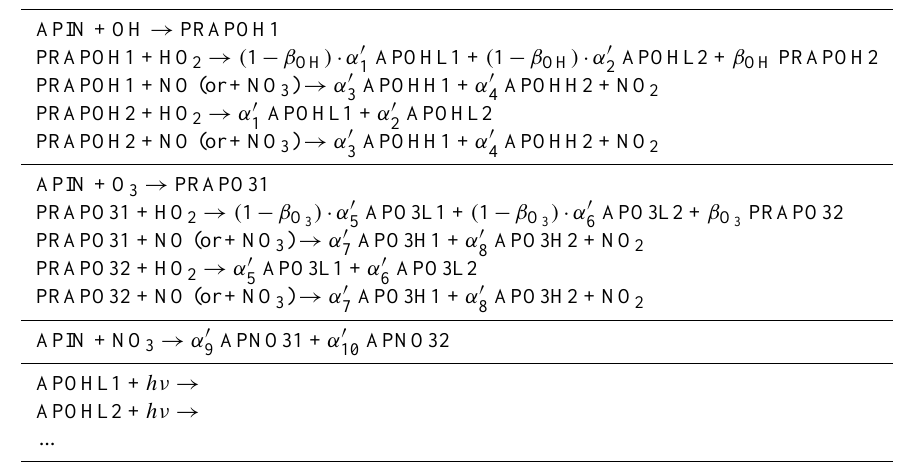
Table 3. Chemical mechanism of the parameter